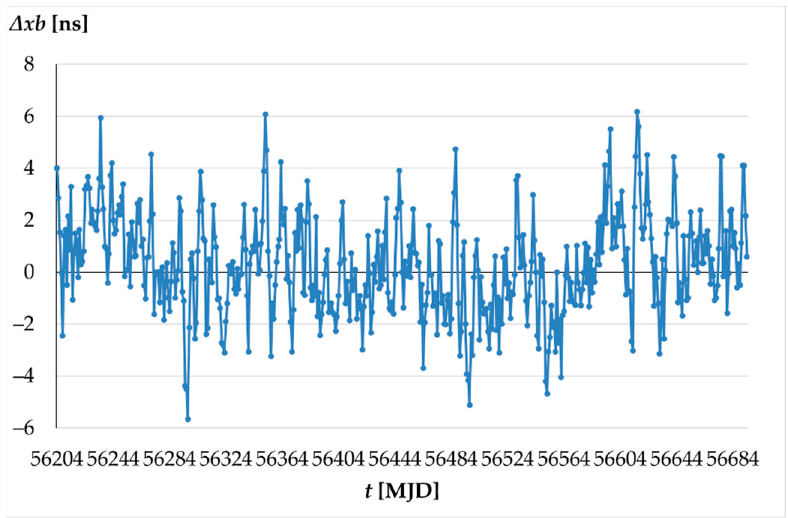
Figure 9. Set of ∆ xb ( t ) values for a period of 491 days.